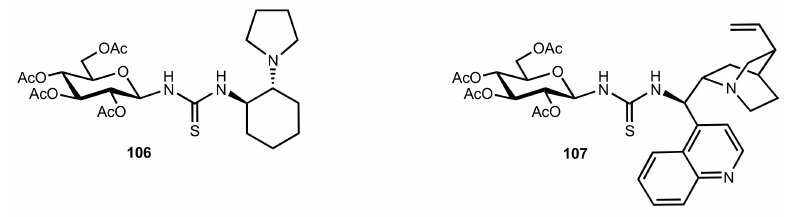
Figure 10. The structure of organocatalysts 106 and 107